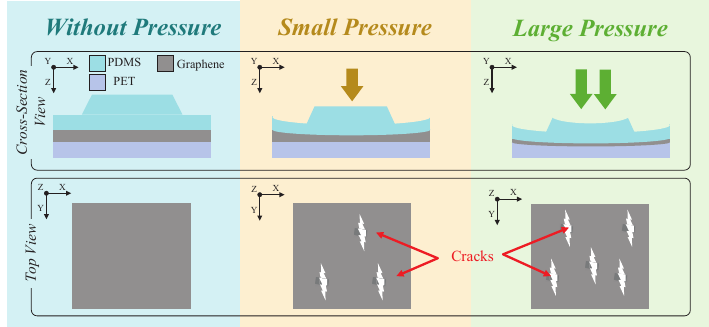
Figure 9. Mechanism of the electronic skin.